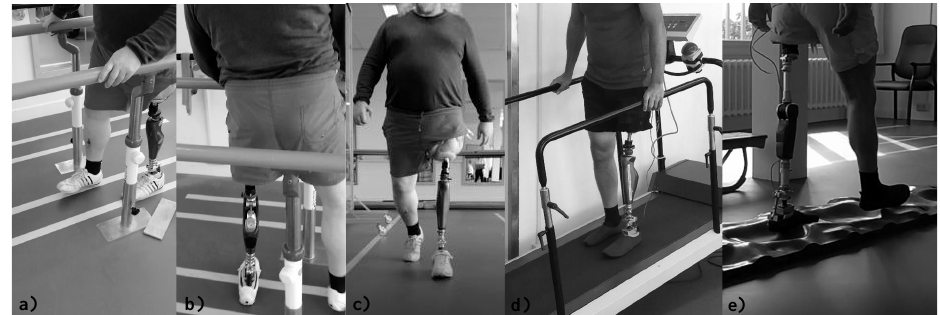
Figure 4. Familiarization activities: ( a ) supported level-ground walking; ( b ) supported level-ground side walking; ( c ) level-ground walking; ( d ) supported downslope walking on a treadmill; ( e ) uneven terrain